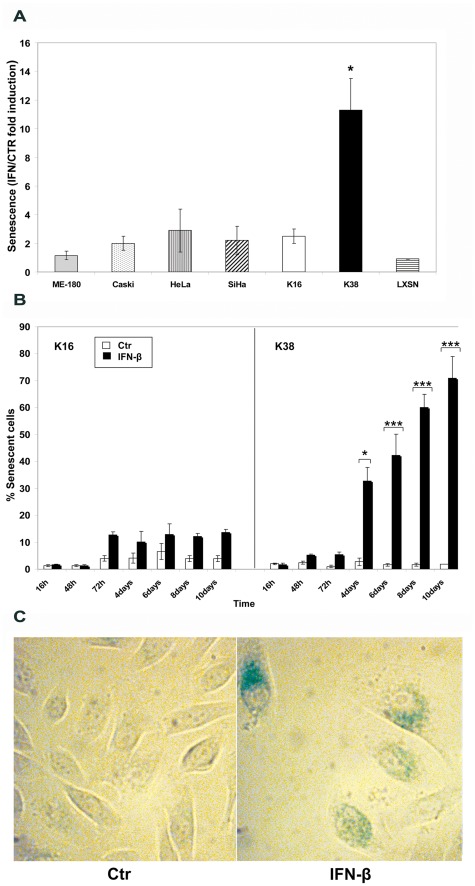
IFN-β induces senescence in K38 cells.(A) Control keratinocytes (LXSN), K16, K38 cells and high risk HPV-positive squamous carcinoma cell lines ME-180, Caski, HeLa and SiHa were treated with IFN-β for 4 days and senescent cells were quantified by counting cells displaying senescent-associated β-galactosidase (SA-βgal) activity at pH 6.0. (B) Percentage of senescent cells in K16 and K38 cells treated with IFN-β for different time points. (C) SA-βgal-positive K38 blue cells observed under a light microscope after 4 days of IFN-β treatment. * = p<0.05; *** = p<0.001.